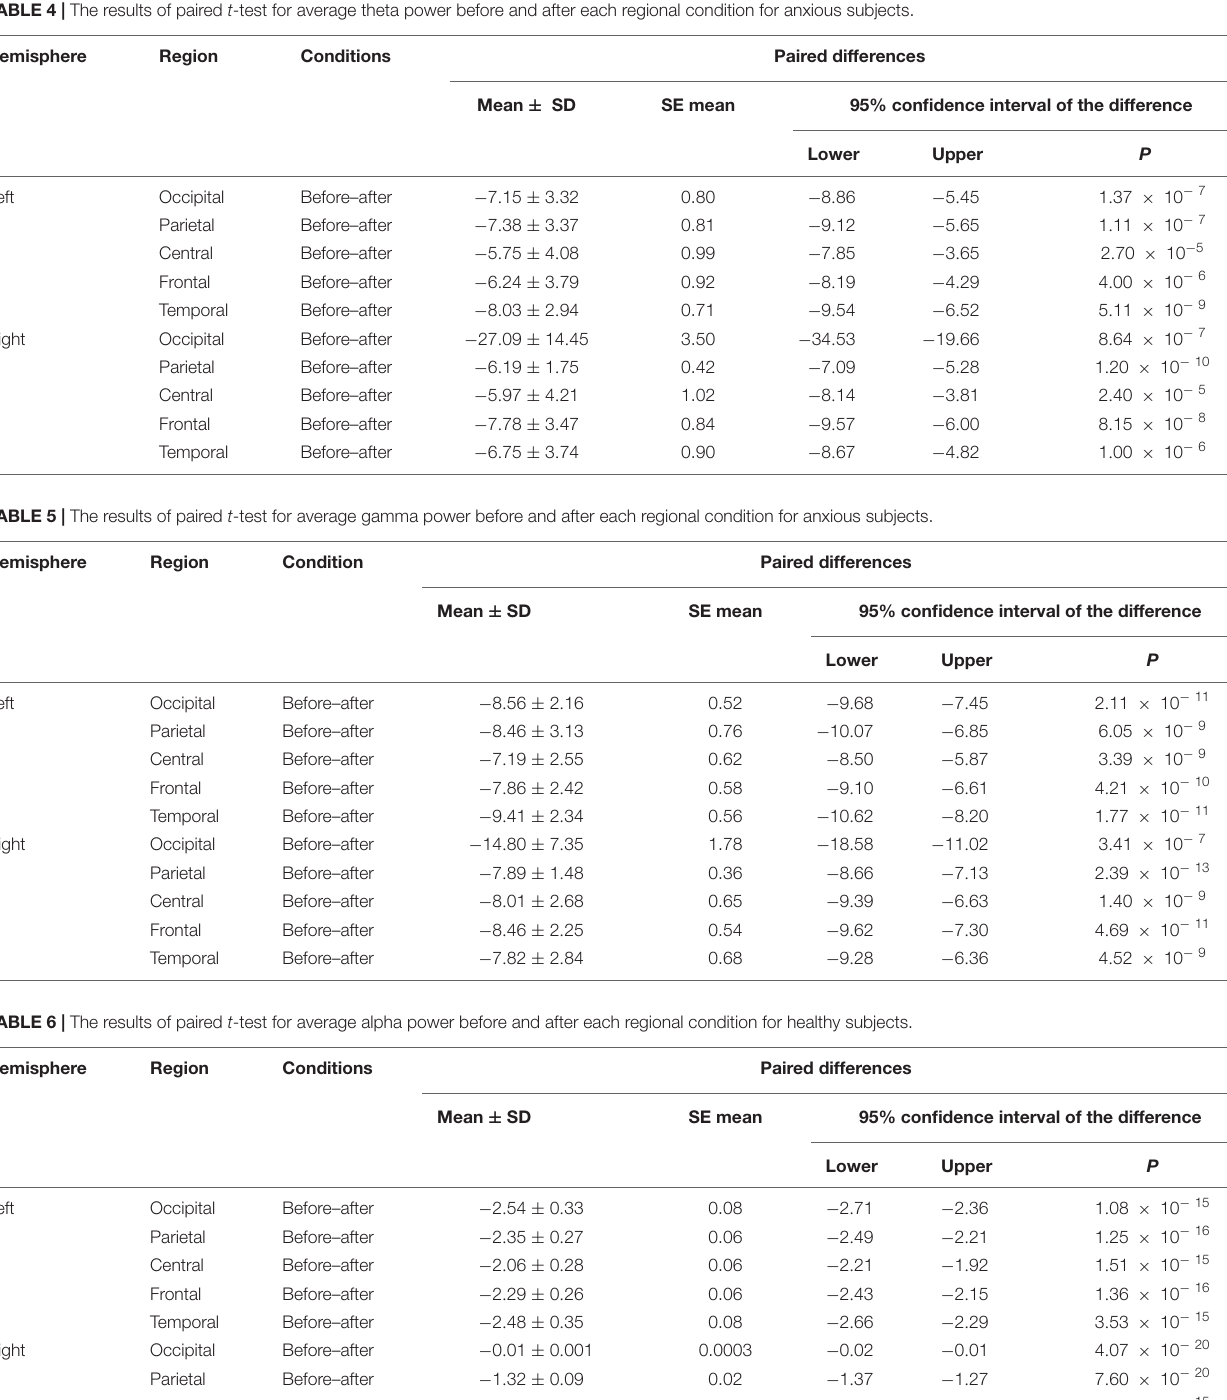
TABLE 4 | The results of paired t -test for average theta power before and after each regional condition for anxious subjects. Hemisphere Region Conditions Paired differences Mean ± SD SE mean 95% confidence interval of the difference Lower Upper P Left Occipital